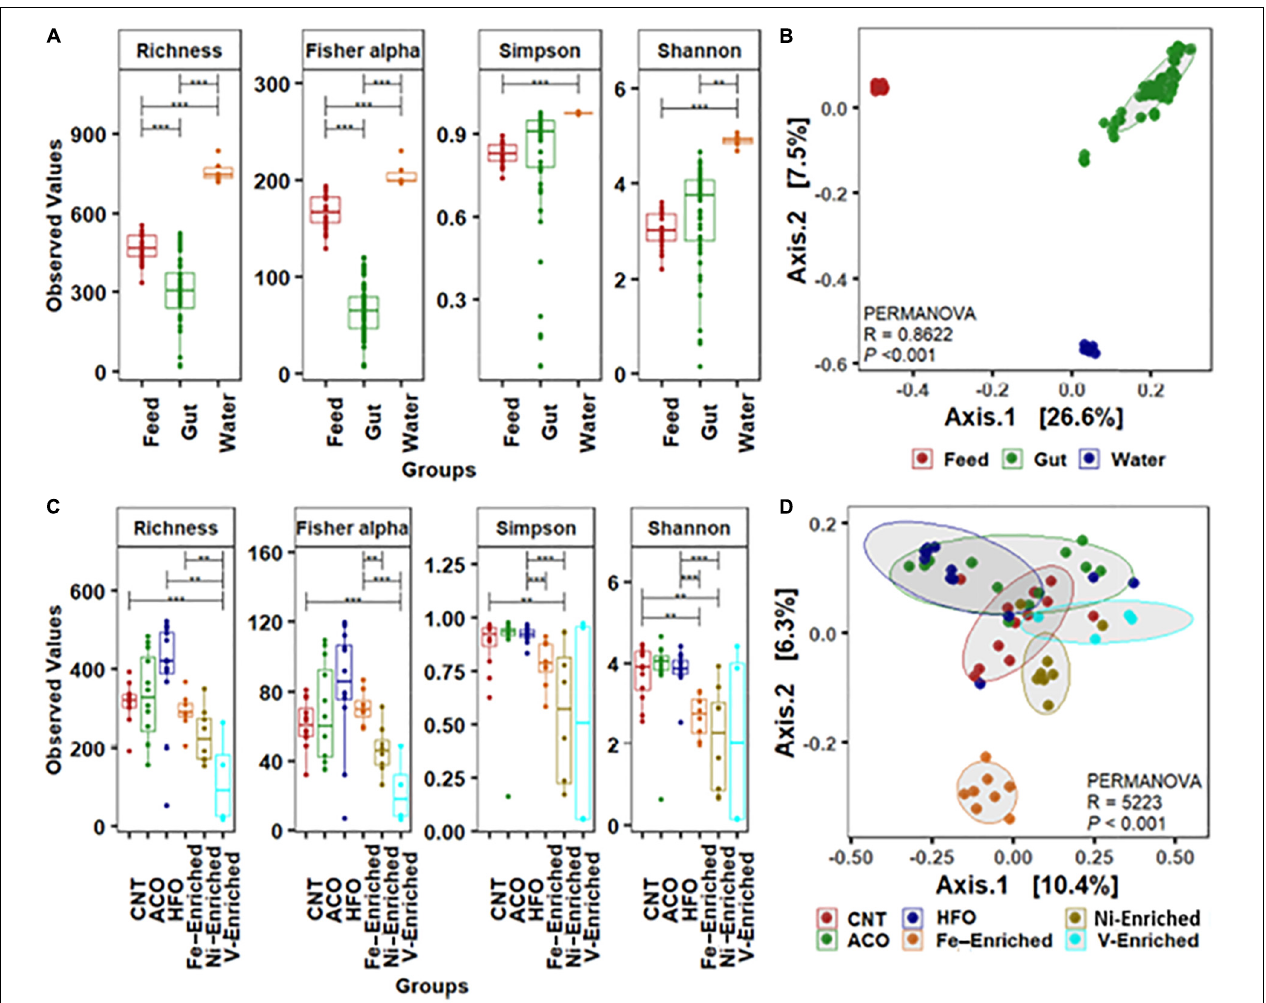
FIGURE 1 | Alpha-beta diversity of bacterial community. (A) Alpha diversity measurements of bacterial communities in the gut, water, and feed. (B) Beta ordination showing clustering of bacterial amplicon sequence variants (ASVs) in the gut, water, and feed. (C) Alpha-diversity measurements of bacterial communities in the gut with six different dietary treatments. (D) Beta ordination showing clustering of bacterial ASVs in the gut of barramundi fed six different diets. Abbreviations: Neg, negative control; ACO, Australian crude oil; HFO, heavy fuel oil. *Significant at an α -level of 0.05. **Significant at an α -level of 0.005. ***Significant at an α -level of